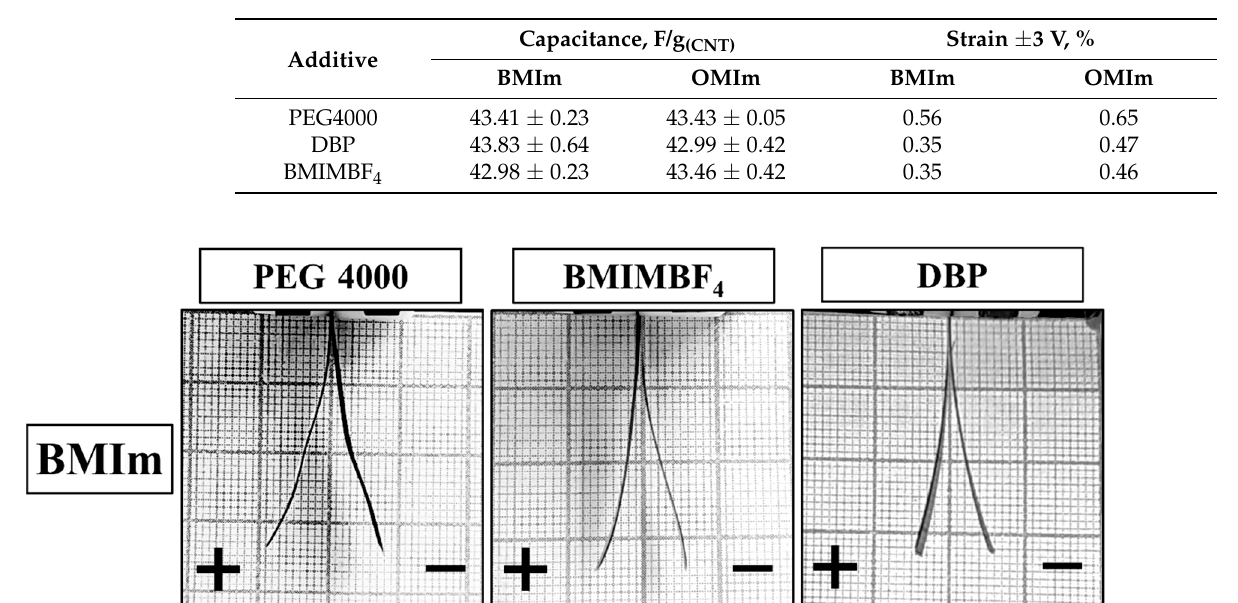
Figure 6. Time profiles of the generated current. Table 7. Electrode specific capacitances and actuation strains.